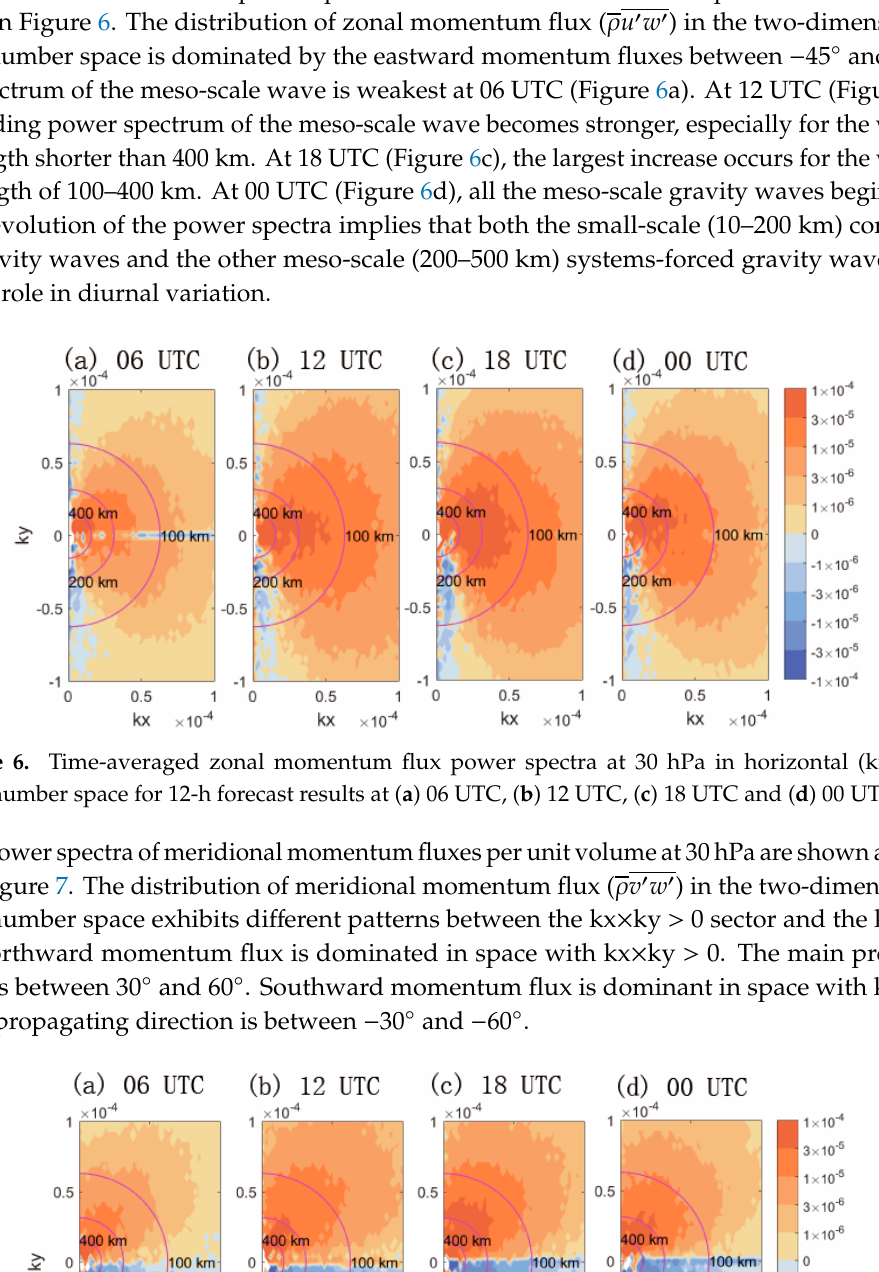
Figure 5. Diurnal variation of ( a ) area-averaged momentum fluxes per unit volume (unit: Pa), ( b ) common logarithm (base 10) of area-averaged momentum fluxes per unit volume (unit: Pa) and ( c ) area-averaged momentum fluxes per unit mass (unit: J/kg) varying with height at 00 UTC (circle), 06 UTC (triangle), 12 UTC (star) and 18 UTC (square) above the main TP (red solid line) and south slope of TP (blue dotted lines). Legends are abbreviations of simulation information. For example, f06 (12) refers to 6(12) − h forecast. t00 (06,12,18) refers to UTC time. TP refers to the main TP region and S refers to the south slope of the TP.